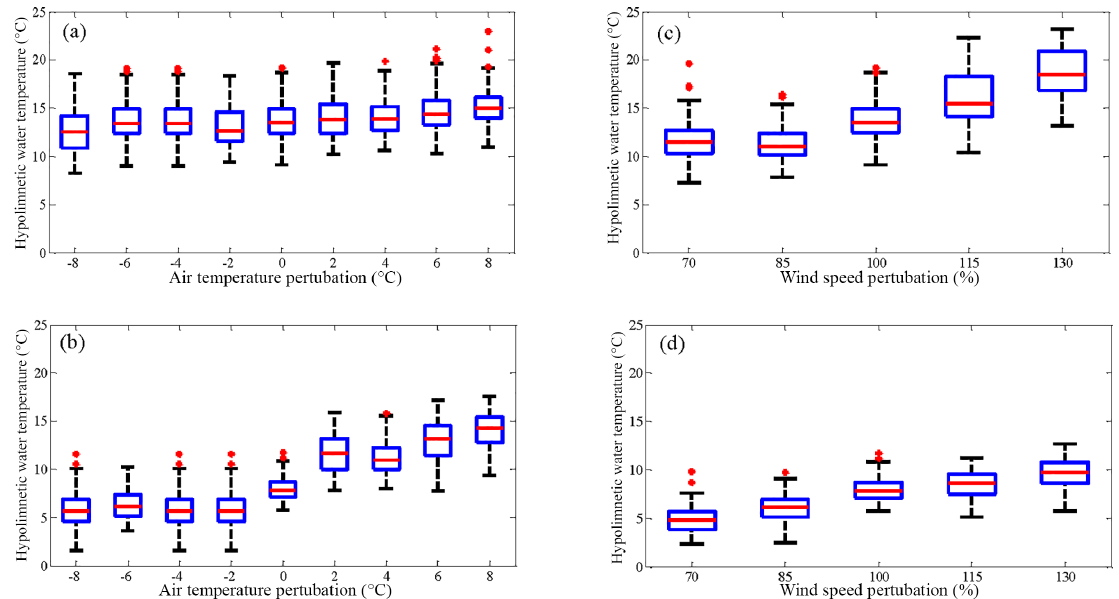
Figure 11. Hypolimnetic water temperatures under select air temperature perturbation scenarios for (a) Lake Mendota and (b) Fish Lake and hypolimnetic water temperatures under select wind speed perturbation scenarios for (c) Lake Mendota and (d) Fish Lake. The box represents the 25th and 75th quartiles and the central line is the median value. The whiskers extend to the minimum and maximum data points in the cases where there are no outliers, which are plotted